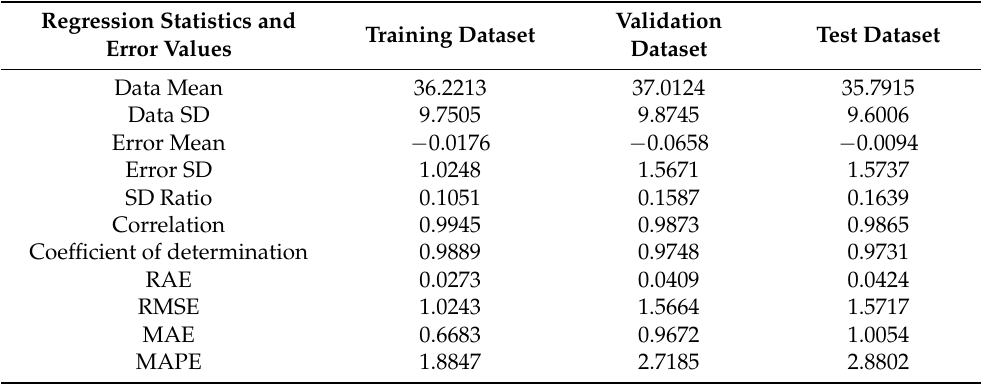
Table 6. Regression statistics and error values for the 33-10-1 TS10 model.